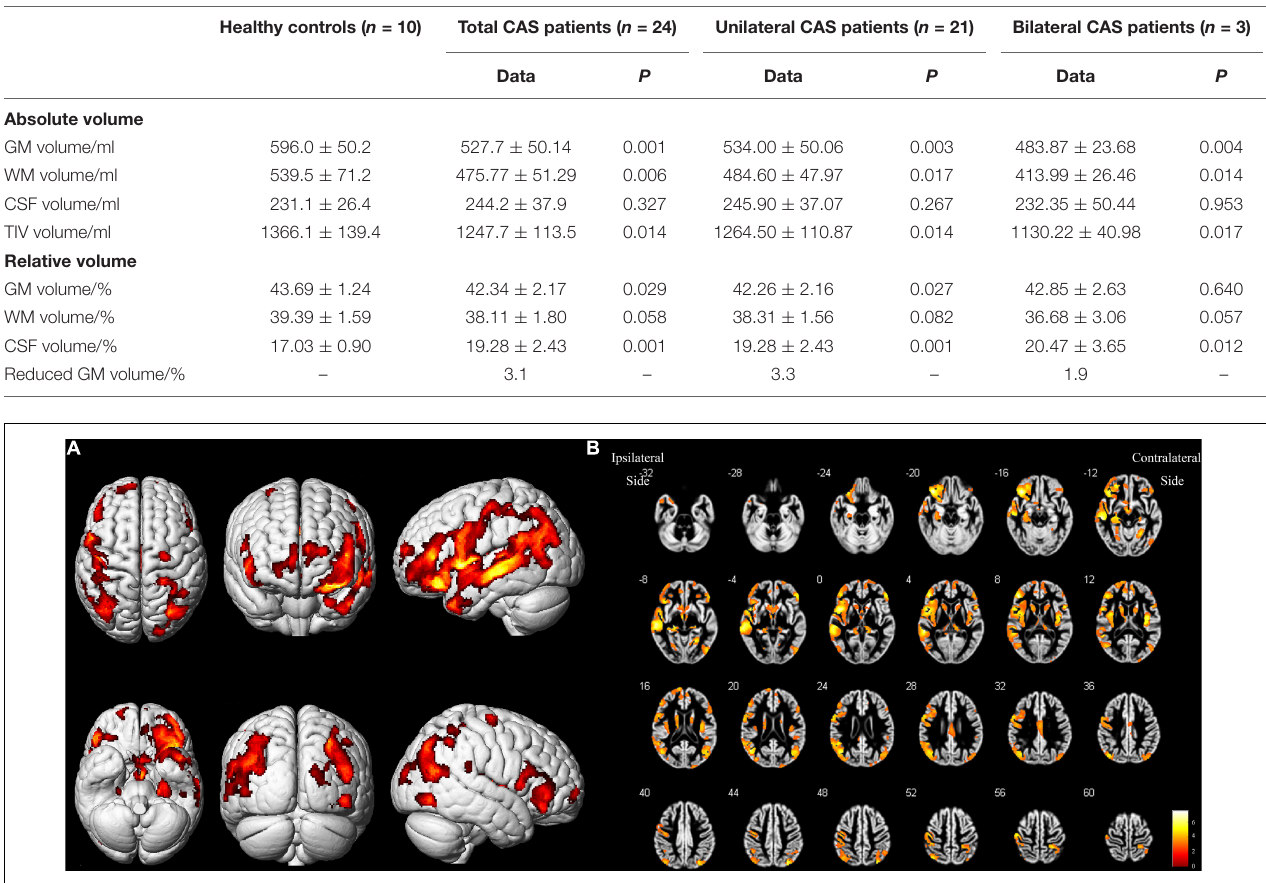
FIGURE 2 | Asymptomatic CAS patients vs. healthy controls. (A) Three-dimensional image. (B) Slice view. Cortical atrophy was observed in bilateral frontal, temporal, and parietal lobes, but occipital lobe and cerebellum were barely affected. L: left, R: